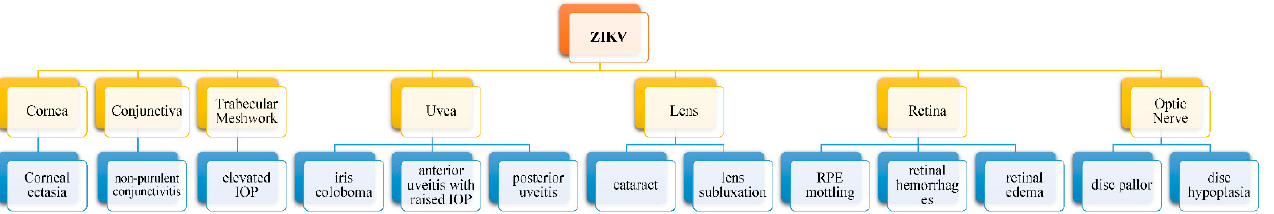
Figure 1. Ocular manifestations of Zika virus